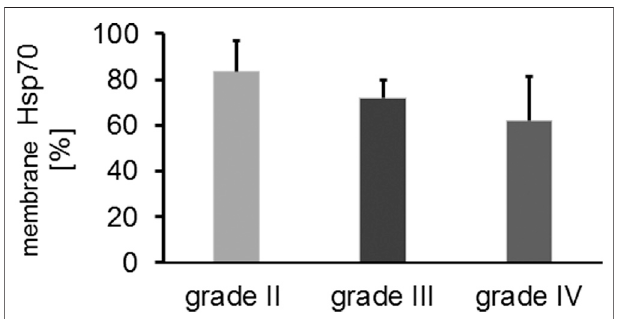
FIGURE 2 | Comparative analysis of the proportion of mHsp70 + tumor cells in grade II ( n (cid:1) 3), grade III ( n (cid:1) 6) and grade IV ( n (cid:1) 28) gliomas (Kruskal Wallis; not signi fi cant,